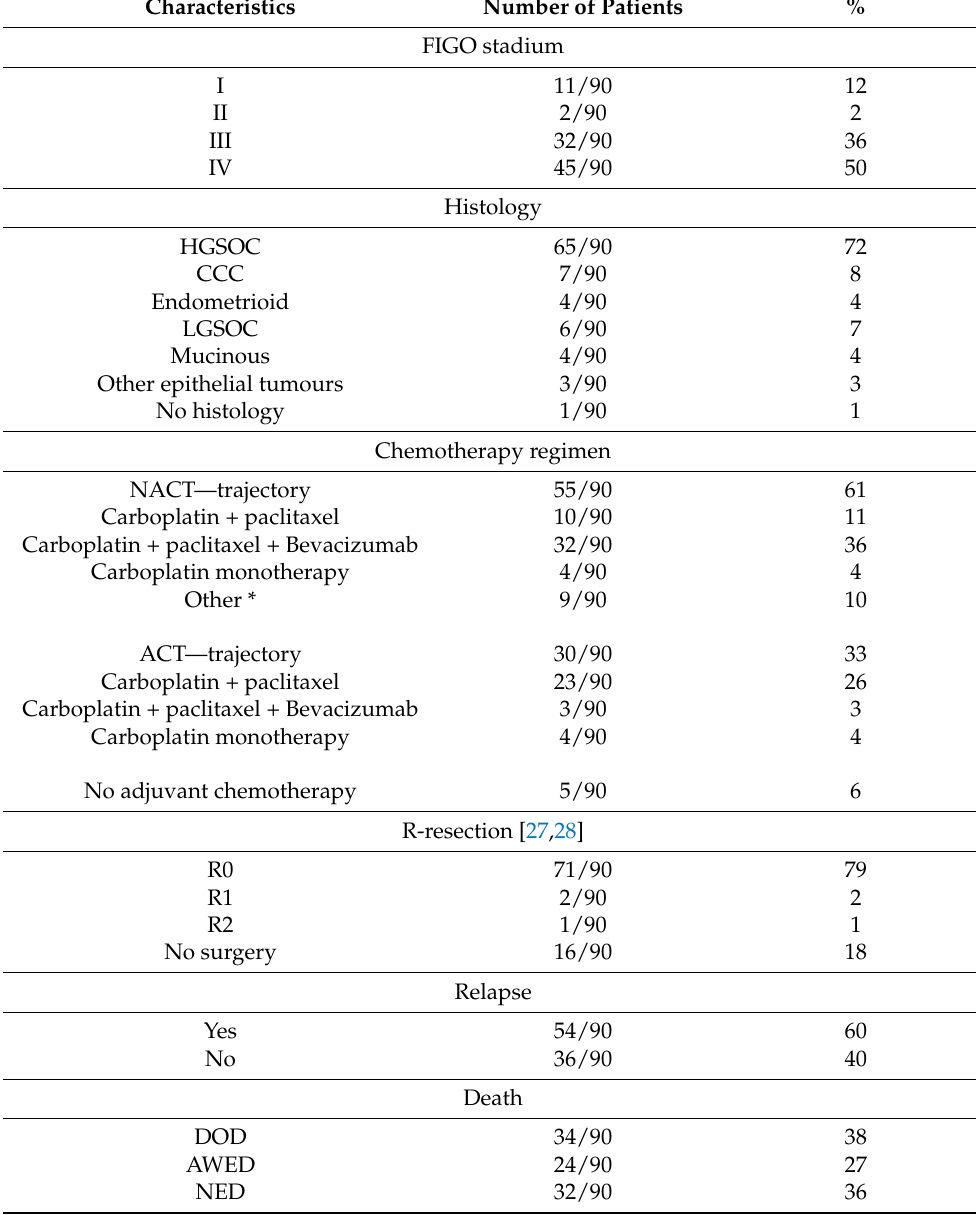
Table 1. Patient characteristics of the study population.